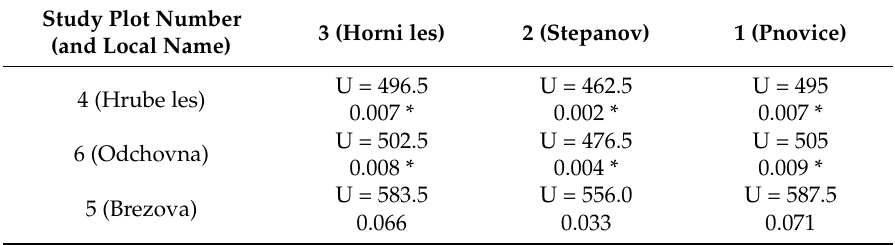
Table 3. Results of Mann-Whitney U tests. (statistically significant differences are highlighted by asterisk). Study Plot Number 3 (Horni